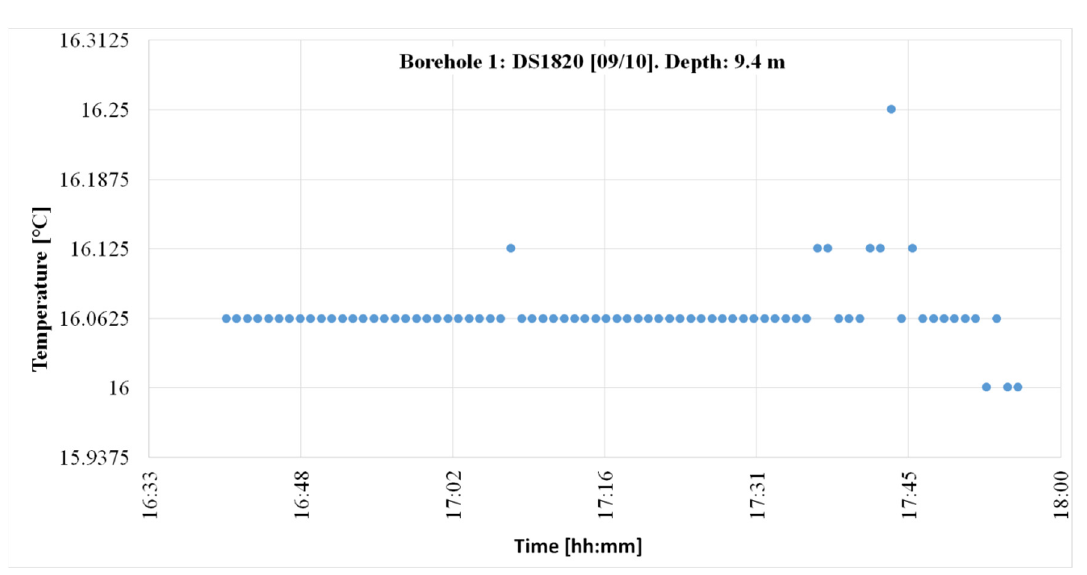
Figure 27. Temperature records from 9 October 2012 at the “Q-Thermie-Uniovi-1” borehole with DS18B20 sensors excluding data.